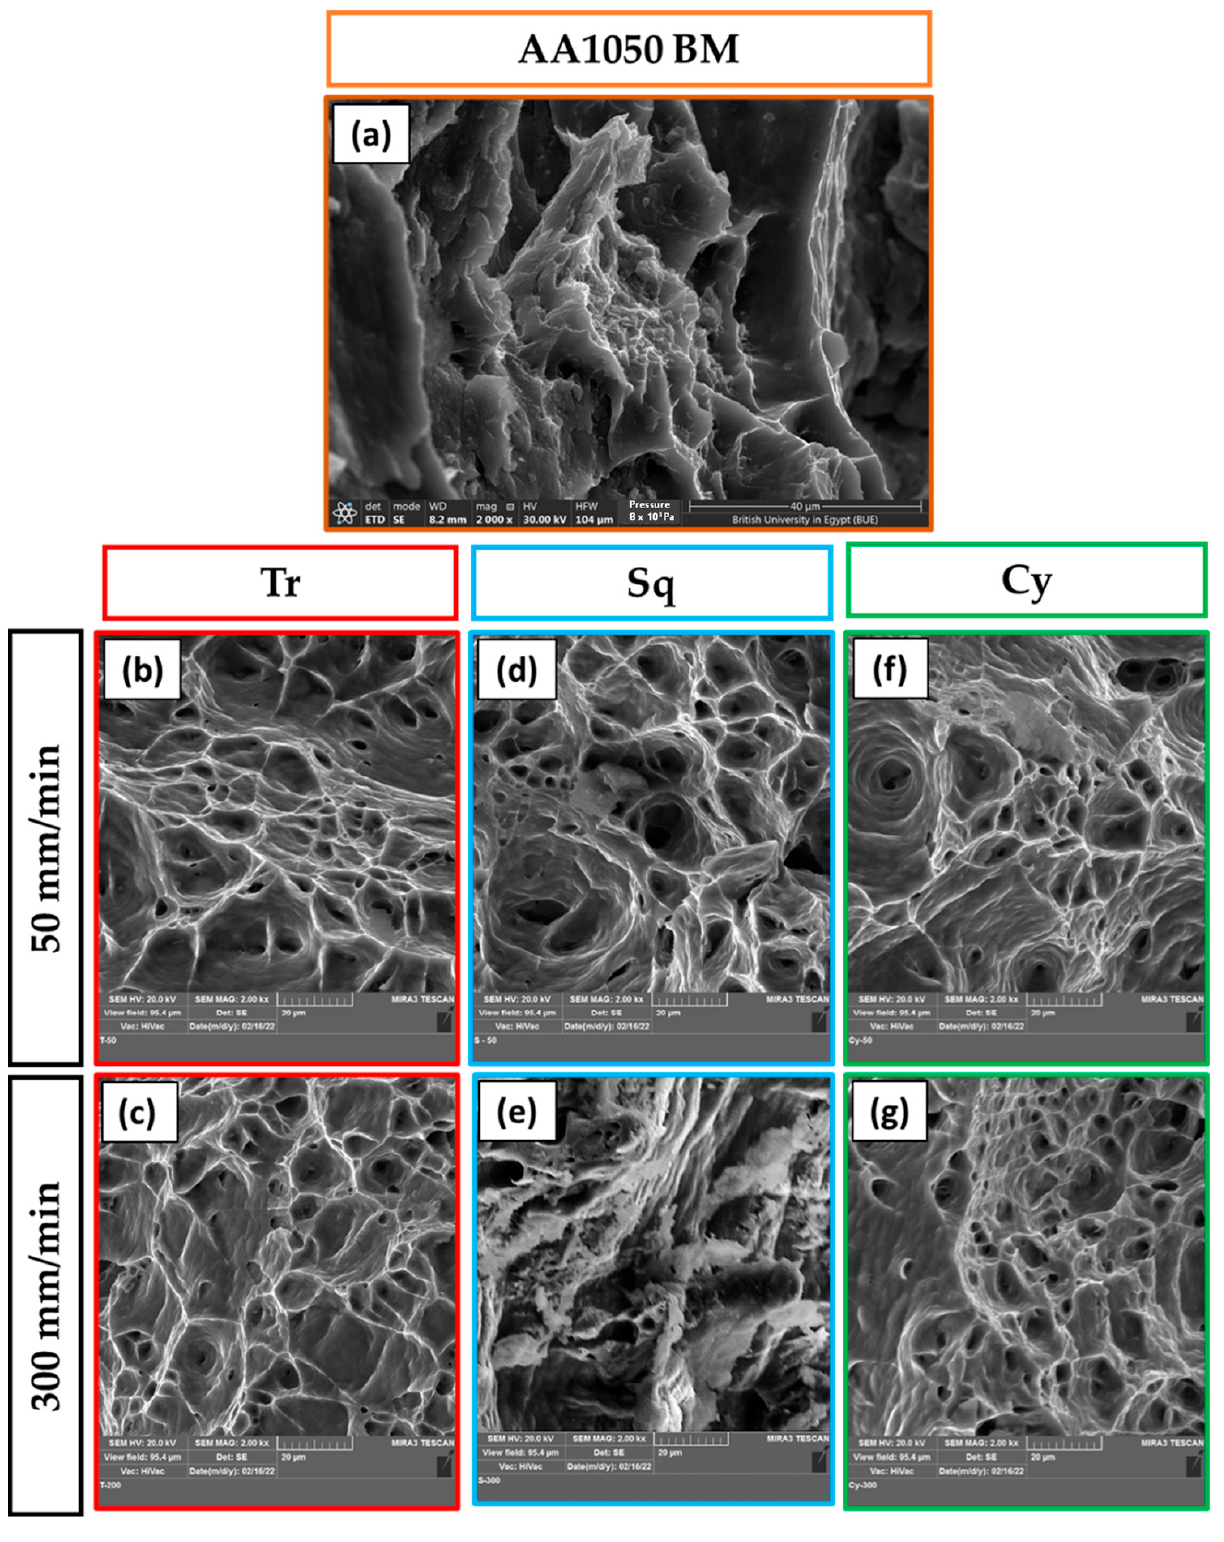
Figure 21. SEM images of the fracture surfaces of the failed specimens after tensile testing for AA1050 BM ( a ) and the processed materials using different pin geometries at the processing parameters of 600 rpm rotation speed and travel speeds of 50 mm/min ( b , d , f ) and 300 mm/min ( c , e , g ).